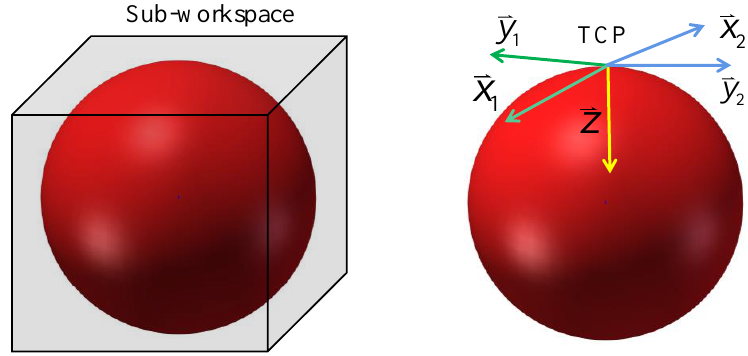
Figure 6. Schematic diagrams of the sub-workspace and TCP